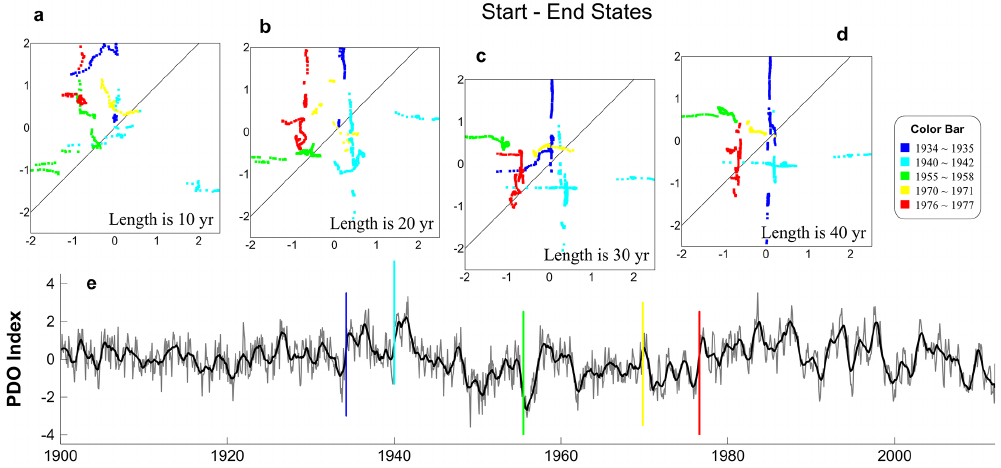
Figure 8. The PDO index and its “start–end states” phase diagram. (a–d) are the phase diagrams: the x axis refers to start state of the abrupt change detected through each sub-sequence, the y axis refers to the end state, and each point in the figure refers to one detection; the different colors refer to different processes with different start moments of abrupt change. (e) is the PDO index: the x axis refers to time and the y axis refers to the